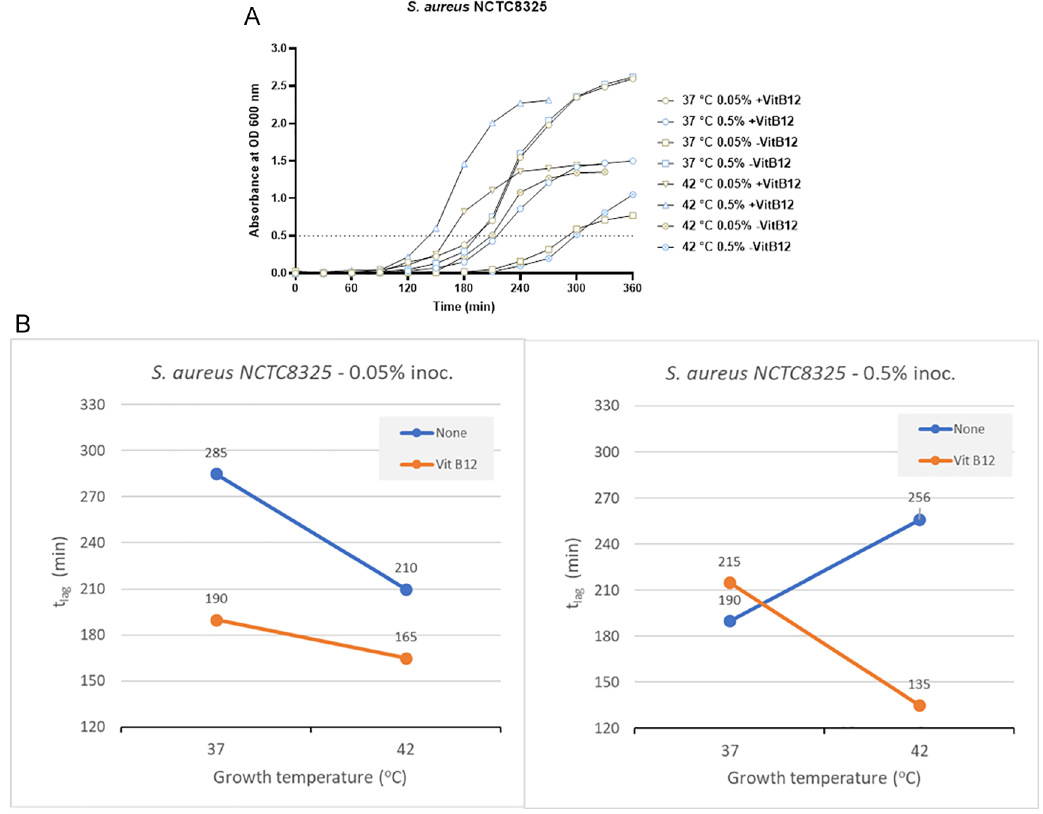
Figure 4. Results for S. aureus NCTC8325 under different growth conditions, including inoculum size, tem- perature, and vitamin B12 supplementation. (A) Growth curves of S. aureus NCTC8325 were obtained in three- factorial designs; at 37 ° C and 42 ° C inoculum sizes 0.05% and 0.5 %, with and without vitamin B12. The dotted line indicates OD 0.5 for estimating the t lag from curves. (B) Effect plot of S. aureus NCTC8325 in minutes (t lag ) to reach optical density